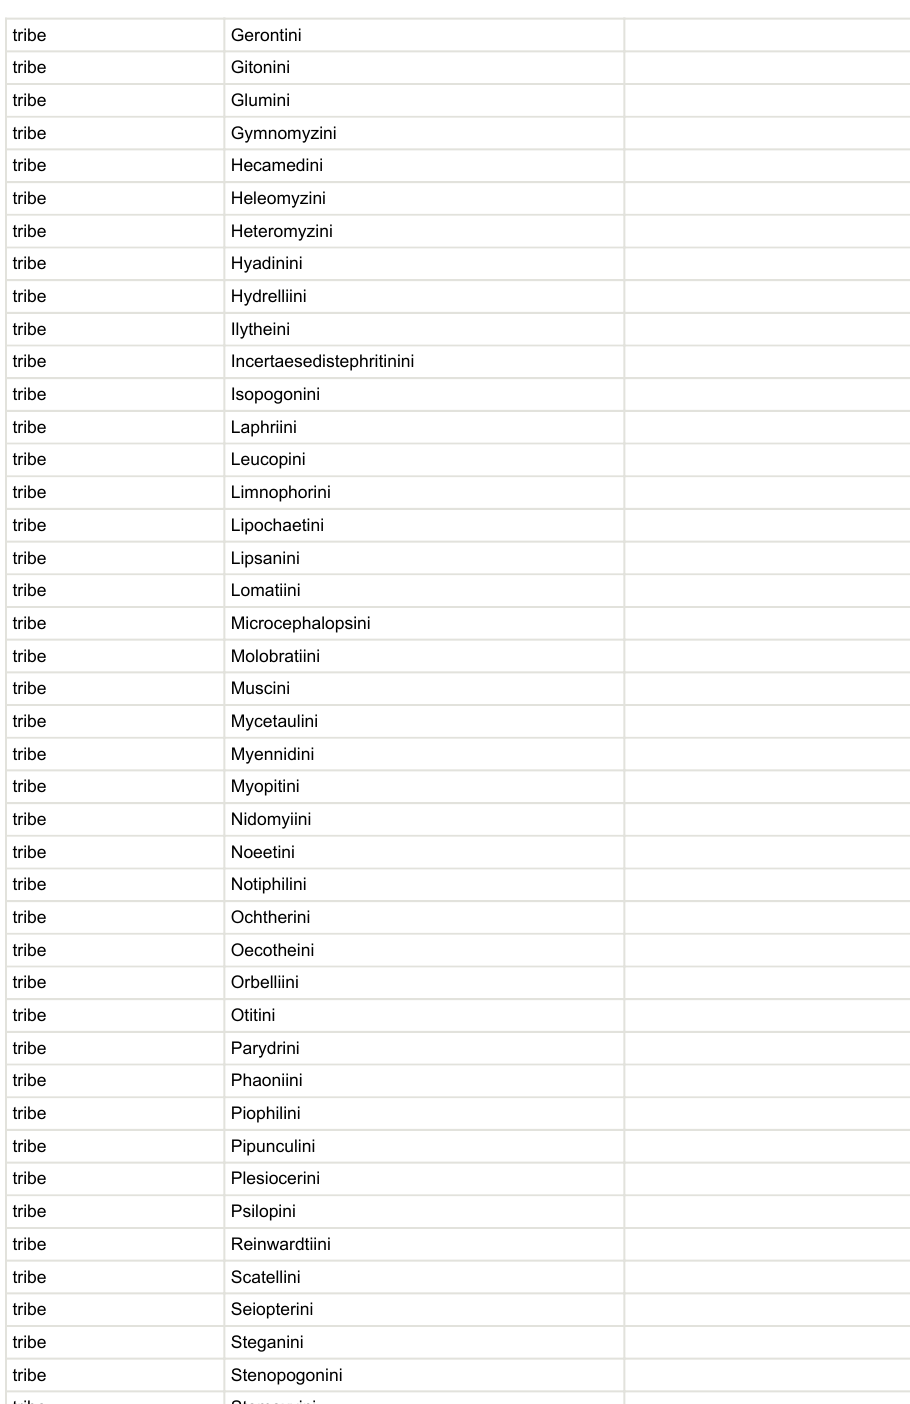
tribe Stenopogonini tribe